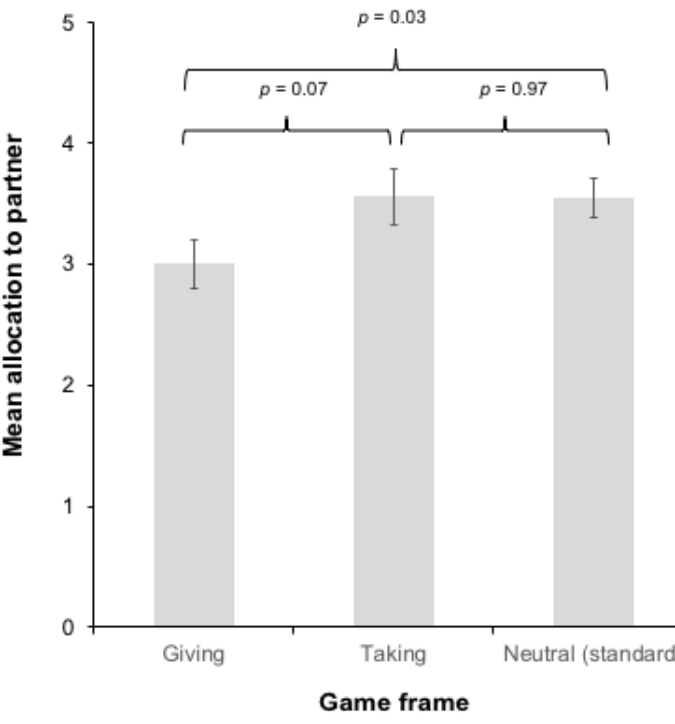
Figure 2. Mean allocation by sample and game frame. For comparison, the mean allocation from a neutrally-framed standard dictator game is provided [59]. Game allocations indicate the amount that the partner received out of 10 points. Error bars indicate one standard error.